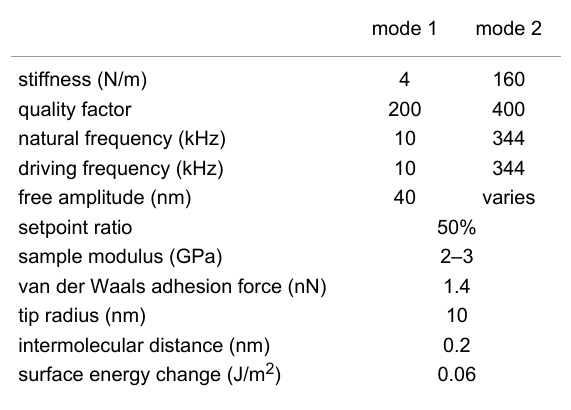
Table 2: Simulation parameters. Hamaker constant and surface energy are tuned to match the experiment. All other values are measured or nominal